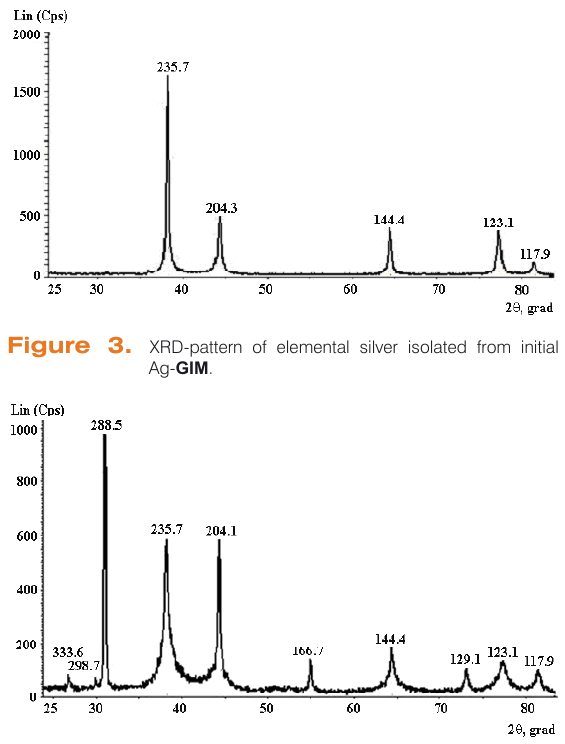
Figure 5. XRD-pattern of substance isolated from Ag- GIM containing «re-precipitated» elemental silver and obtained with using of solution containing ethanediamine-1,2 in concentration 20.0 g L –1